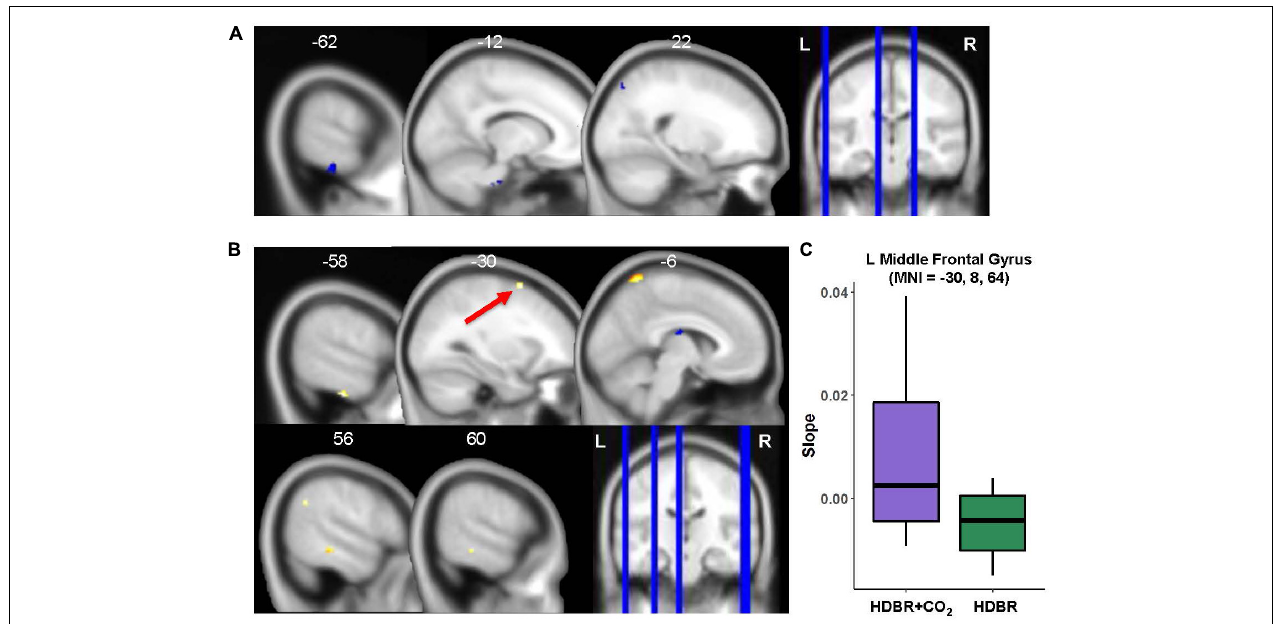
FIGURE 7 | HDBR + CO 2 vs. HDBR group comparisons. (A) Regions of intercept differences between HDBR + CO 2 and HDBR groups. (B) Regions of slope differences between HDBR + CO 2 and HDBR groups. Results overlaid onto MNI standard template; non-parametric p < 0.0005, k = 10. Cool colors indicate regions where the intercept or slope for the HDBR + CO 2 group was numerically less than the intercept or slope for the HDBR group. Warm colors indicate regions where the slope for the HDBR + CO 2 group was numerically greater than the slope for the HDBR group. (C) Example slope values extracted from L Middle Frontal Gyrus (i.e., the cluster with greatest T value for the HDBR + CO 2 > HDBR contrast). Here, the HDBR + CO 2 group showed increased activation of this region across bed rest, while the HDBR group showed increased deactivation of this region across bed rest. TABLE 5 | Regions with intercept differences between HDBR + CO 2 and HDBR subjects. Extent ( k ) Peak T -value Non-parametric Peak p -value MNI coordinates (mm) x